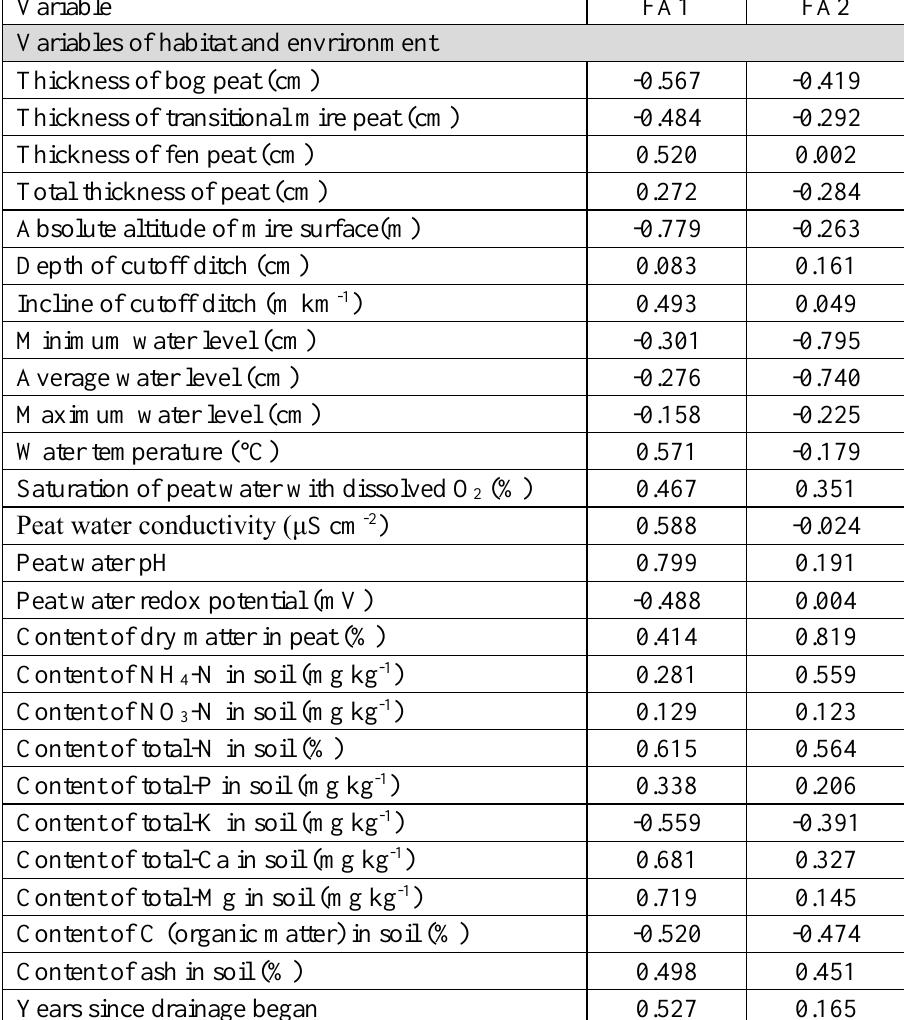
layer variables such as sum of girths (r Spearman = -0.87; Figure 10) and sum of heights (r Spearman = -0.87) of trees, tree layer crown closure (r Spearman = -0.81; Figure 11) and tree layer canopy cover derived from LIDAR data (r Spearman = -0.75; Figure 12) are most strongly correlated with the distance factor. The girths and heights of trees, as well as canopy closure of the tree layer, decrease rather steeply up to the log- distance value 2.3, i.e. up to a distance of ~ 200 m from the cutoff ditch. This trend continues with increasing distance from the ditch even though there are relatively few data points. complementary information. This variable decreases